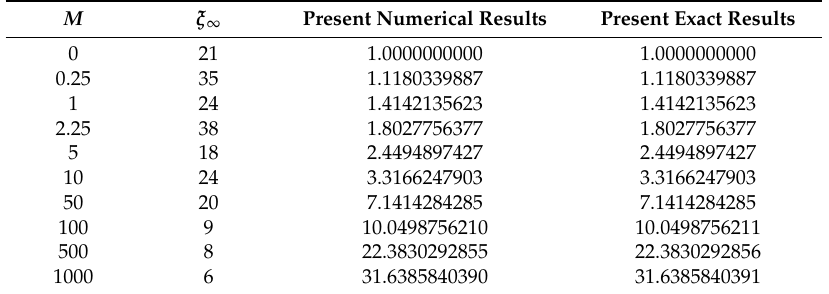
Table 2. Validation of our numerical results obtained by Chebyshev–Gauss–Lobatto spectral method (CGLSM) for − Re 0.5 s Cf s with those of the closed form exact solution, in the case where ε = φ = 0 and κ = ∞ , when N = 100.